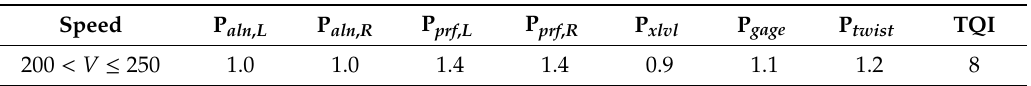
Table 2. Value of the TQI and geometric parameters (unit: mm). KM